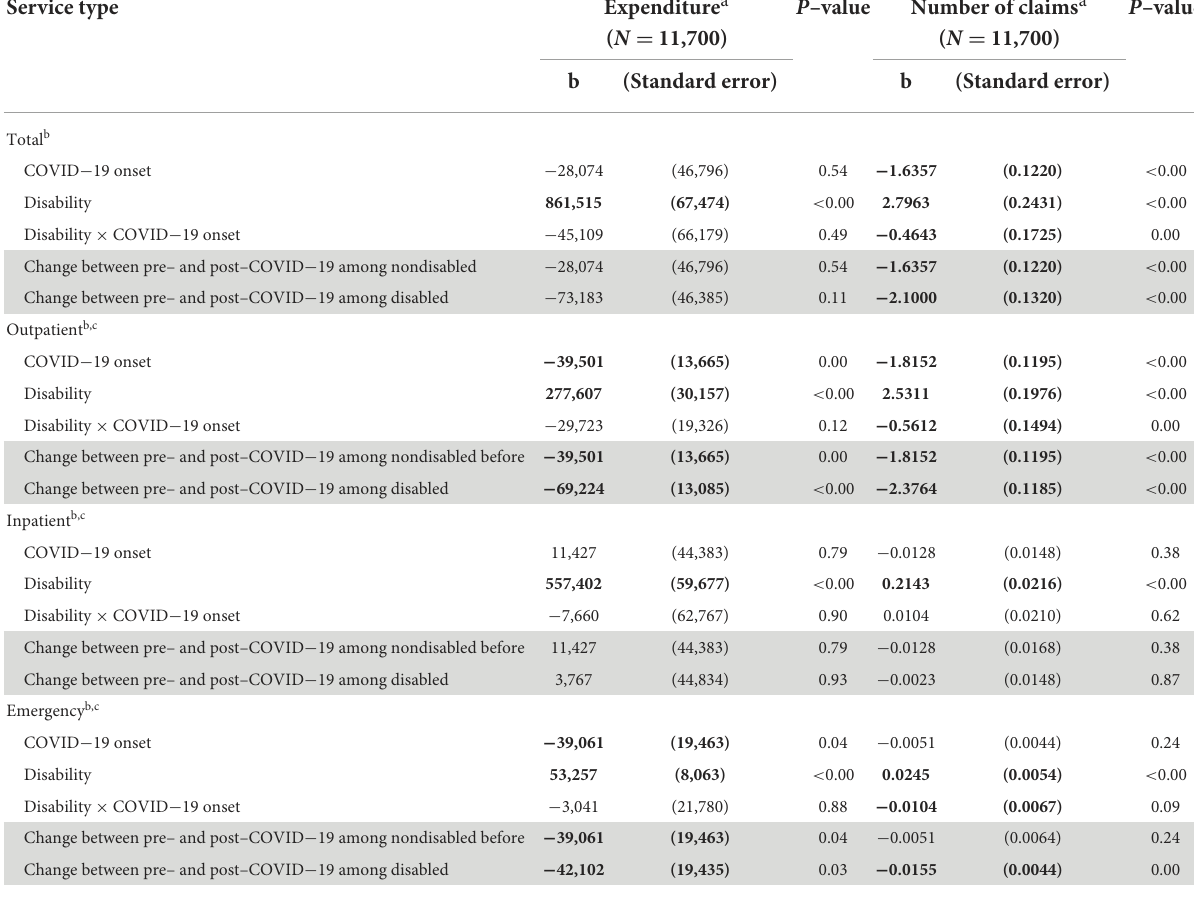
TABLE 2 Multivariate random–effects regression of the incremental change in healthcare service utilization in the early COVID − 19 pandemic compared to pre–pandemic for people with disabilities, controlling for the parallel difference among people without disabilities d